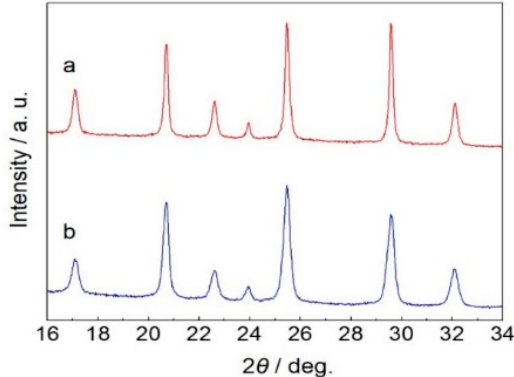
Figure 7. XRD patterns of LiMn 0.4 Fe 0.6 PO 4 calcined from LiMnPO 4 and LiFePO 4 with different morphology: ( a ) LiMnPO 4 nano-plates with lengths of less than 100 nm + LiFePO 4 plates with lengths of around 500 nm; ( b ) LiMnPO 4 nano-plates with lengths of less than 100 nm + a LiFePO 4 micro-sphere with a diameter of over 5 μ m.